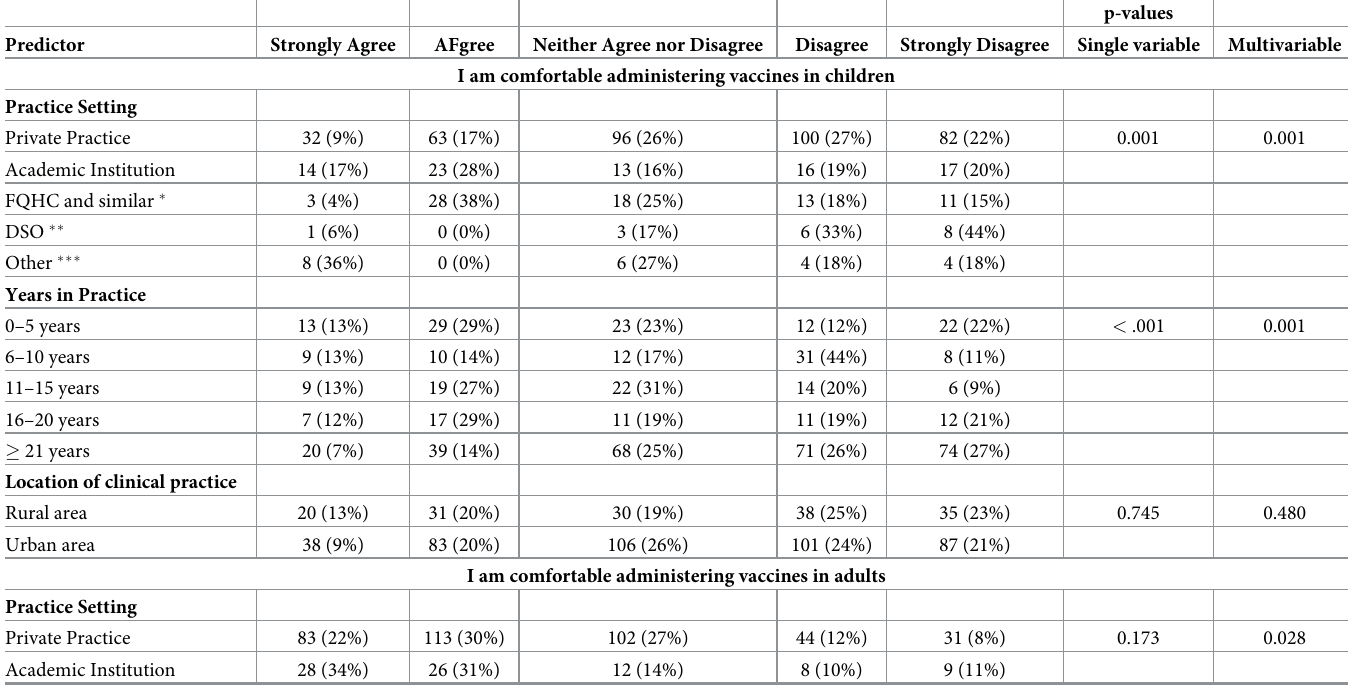
Table 4. Beliefs, attitudes, and comfort levels around vaccination by participant